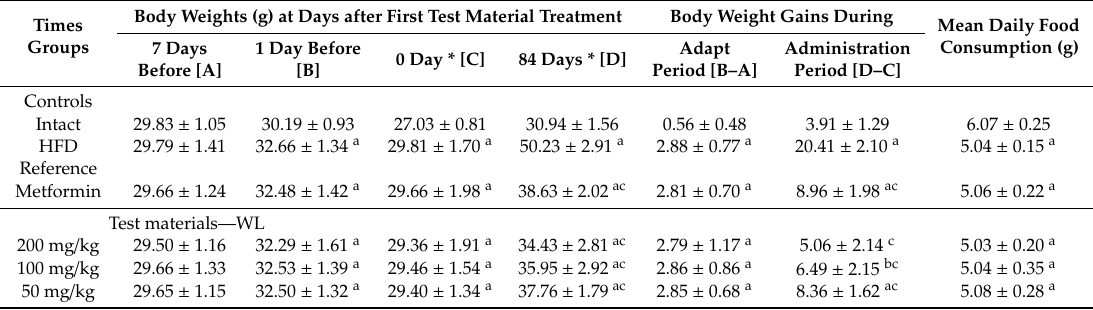
Table 1. Changes in body weight and mean daily food consumption in NFD or HFD supplied mice. Times